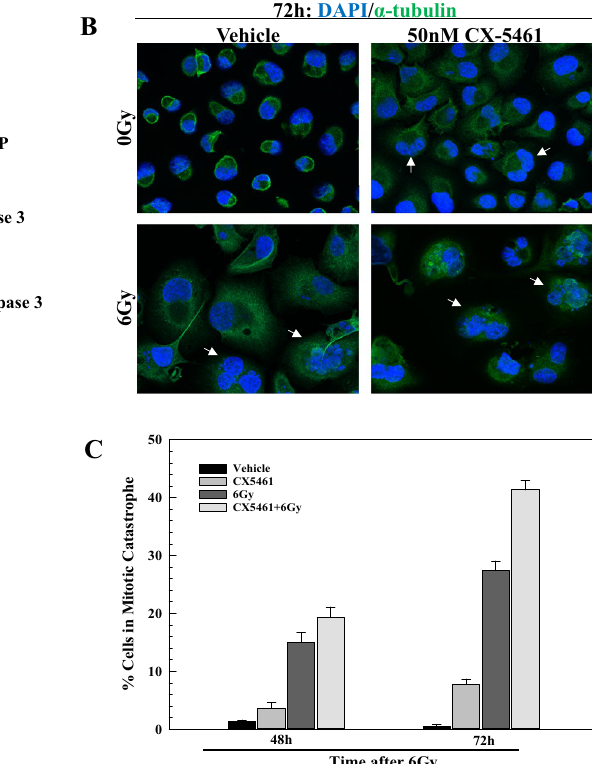
Figure 3. The effect of CX-5461, radiation and the combination on the mode of cell death in PANC-1 cells. ( A ) Western blot analysis of apoptosis in PANC-1 cells. 50 nM CX-5461 was added to cultures 1 h prior to irradiation (6 Gy), and cells were harvested at the indicated time points. Staurosporine (STS; 1 µM for 3 h) was used as positive control for apoptosis induction. Cell lysates were immunoblotted for PARP and caspase 3, with α-tubulin as a loading control. Full-length blots are presented in Supplementary Information. ( B ) Representative images of mitotic catastrophe in PANC-1 cells. 50 nM CX-5461 was added to cultures 1 h prior to irradiation (6 Gy) and removed 24 h post-irradiation with cells collected at 72 h. Examples of cells undergoing mitotic catastrophe are indicated by white arrows. ( C ) Quantitation of mitotic catastrophe. CX-5461 (50 nM) was added to cultures 1 h prior to irradiation (6 Gy) and removed 24 h post-irradiation with cells collected at the indicated time points. Cells containing micronuclei, a nucleus with 2 or more lobes, or multiple nuclei were scored positive for mitotic catastrophe. 50–100 cells were scored per treatment group. Values represent the mean ± SEM for three independent experiments. * p < 0.05 by Student’s